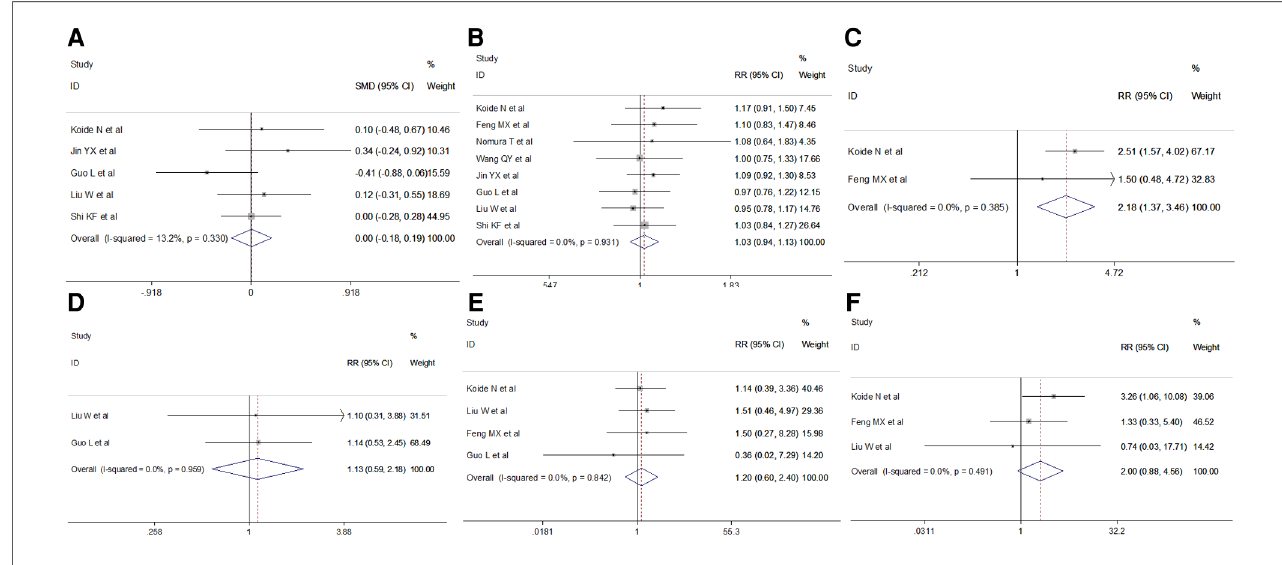
FIGURE 3 Meta-analysis of clinical features: ( A ) Age; ( B ) Gender; ( C ) Pulmonary disease; ( D ) Hypertension; ( E ) Diabetes; ( F ) Cardiac